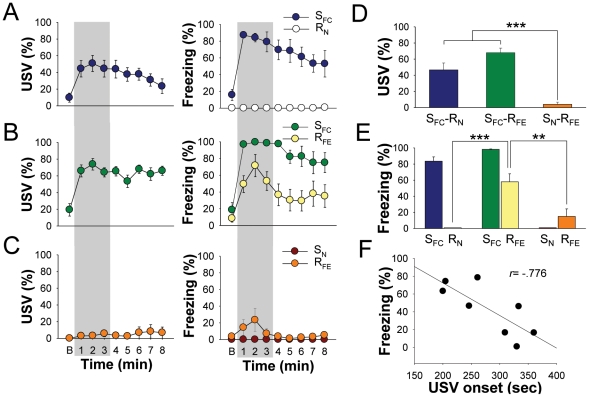
Results from three groups of sender-receiver pairs (n = 16 rats/pair).fear-conditioned sender and naïve receiver (SFC-RN); fear-conditioned sender and fear-experienced receiver (SFC-RFE); and naïve sender and fear-experienced receiver (SN-RFE). (A–C) Mean (± SEM) percentage time spent emitting USV and displaying freezing by S and R rats during baseline and 8 min tone CS presentation. (D, E) Group differences in USV (F2,23 = 28.583, P<.0001) and freezing (F5,47 = 52.743, P<.0001) during the first 3-min period of the pair-testing (grey sections, A through C). *, ** and *** denote P<.05, P<.001 and P<.0001, respectively, Bonferroni test. (F) A significant correlation between RFE animals' USV onset latencies during 3 unsignaled footshocks on day 1 and the RFE animals' freezing levels during SFC-RFE pair-testing on day 2 (r = −.779, P = .02).